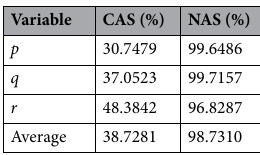
Table 5. The fitness of rotational states of UAV in the presence of multiple abrupt faults in τ .